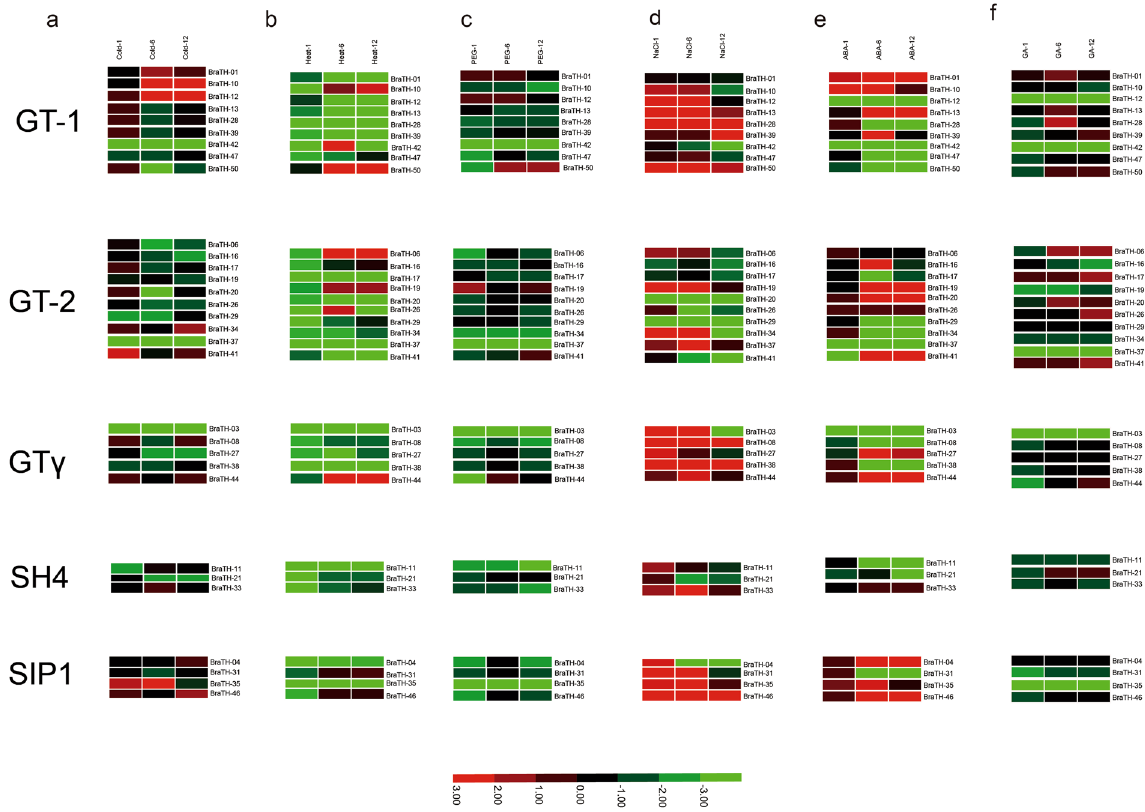
Figure 7. Expression analysis of BraTH Genes under six abiotic stress treatments. ( a,b,c,d,e,f ) Heat map representation the trihelix genes under six stress treatments, that is, Cold, Heat, PEG, NaCl, ABA and